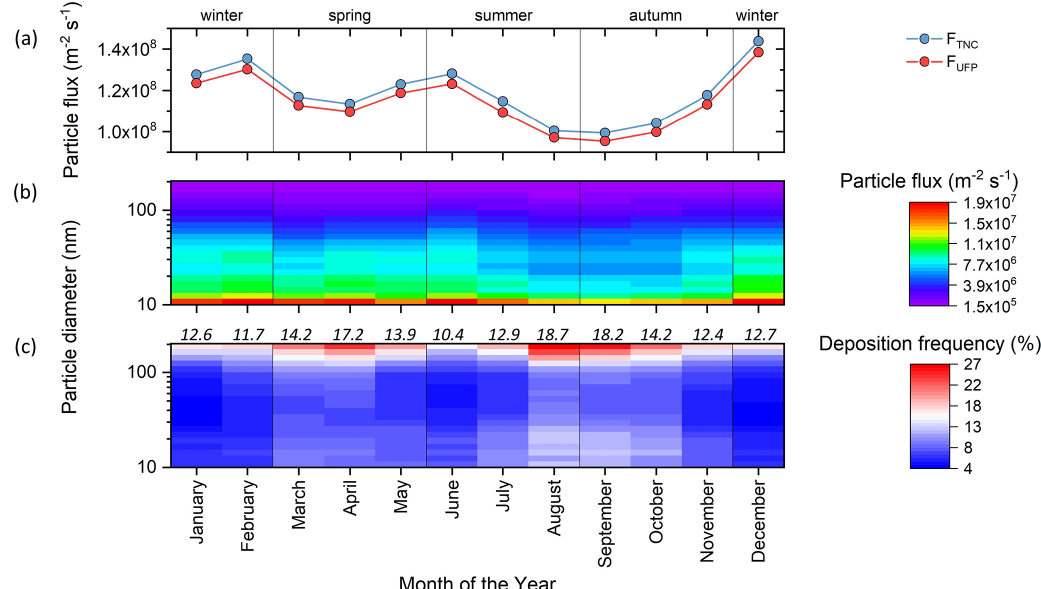
Figure 10. Monthly variation of (a) average F TNC and F UFP , (b) size-resolved average particle number fluxes, and (c) the size-resolved frequency of particle deposition. In panel (c) the values given in italics quantify the maximum difference in deposition frequency within each monthly size spectrum (max. (cid:49) deposition frequency, given in percentage